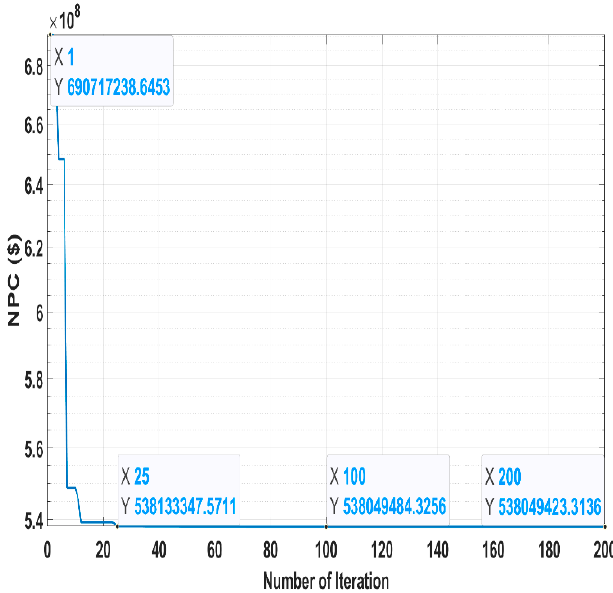
Figure 9. Convergence Plot (Case-03).